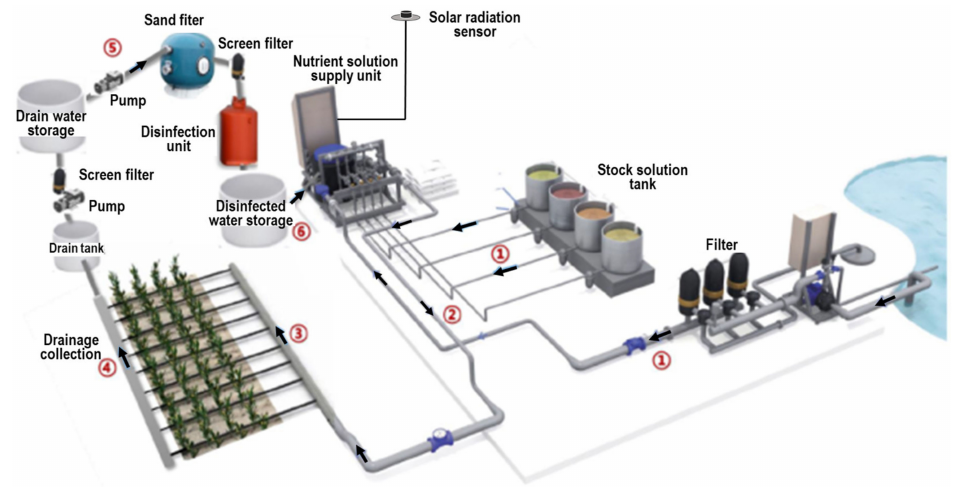
Figure 2. A closed hydroponic system consisting of a nutrient solution supply unit to blend fresh water with the recirculated nutrient solution (drainage water), the injection of concentrated stock solutions, and automated irrigation, as well as the filtering and disinfection of stored drainage water. The number indicates the flow of the nutrient solution in the closed hydroponic system.